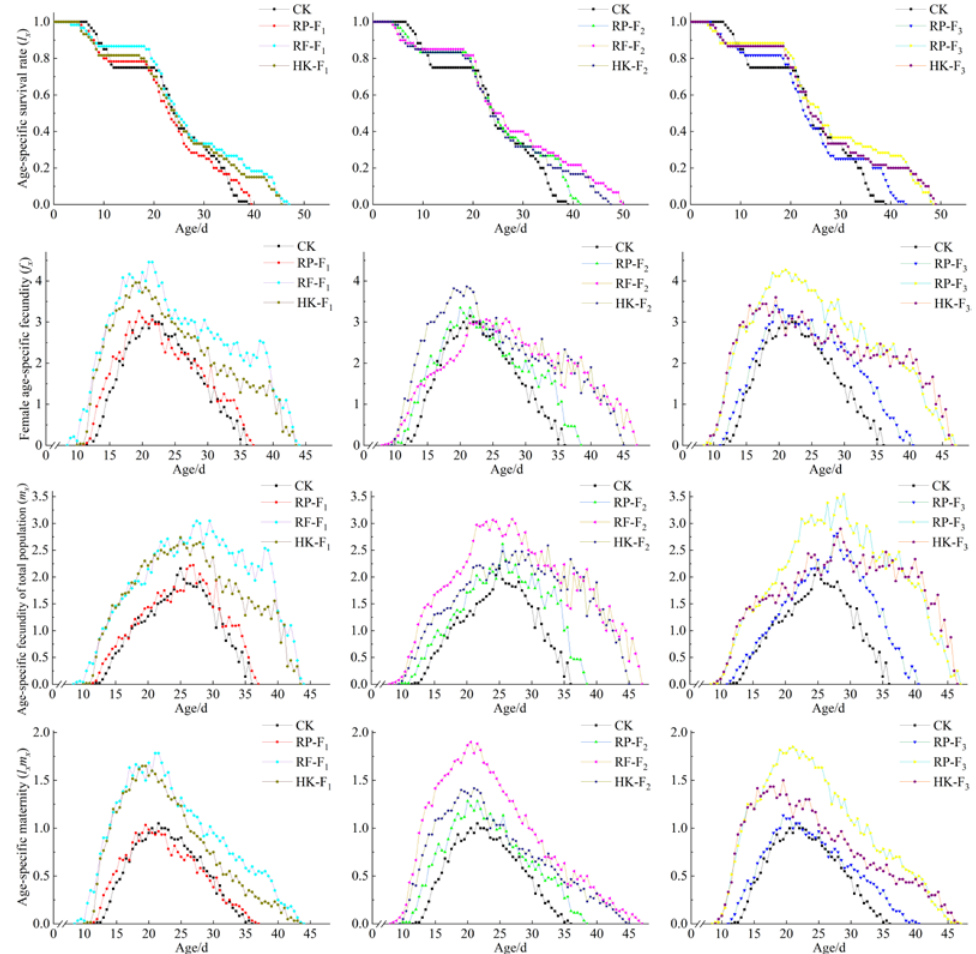
Figure 2. Age-specific survival rate ( l x ), female age-specific fecundity ( f x ), age-specific fecundity of total population ( m x ), and age-specific maternity ( l x m x ) of F. occidentalis fed on different food types in F 1 , F 2 , and F 3